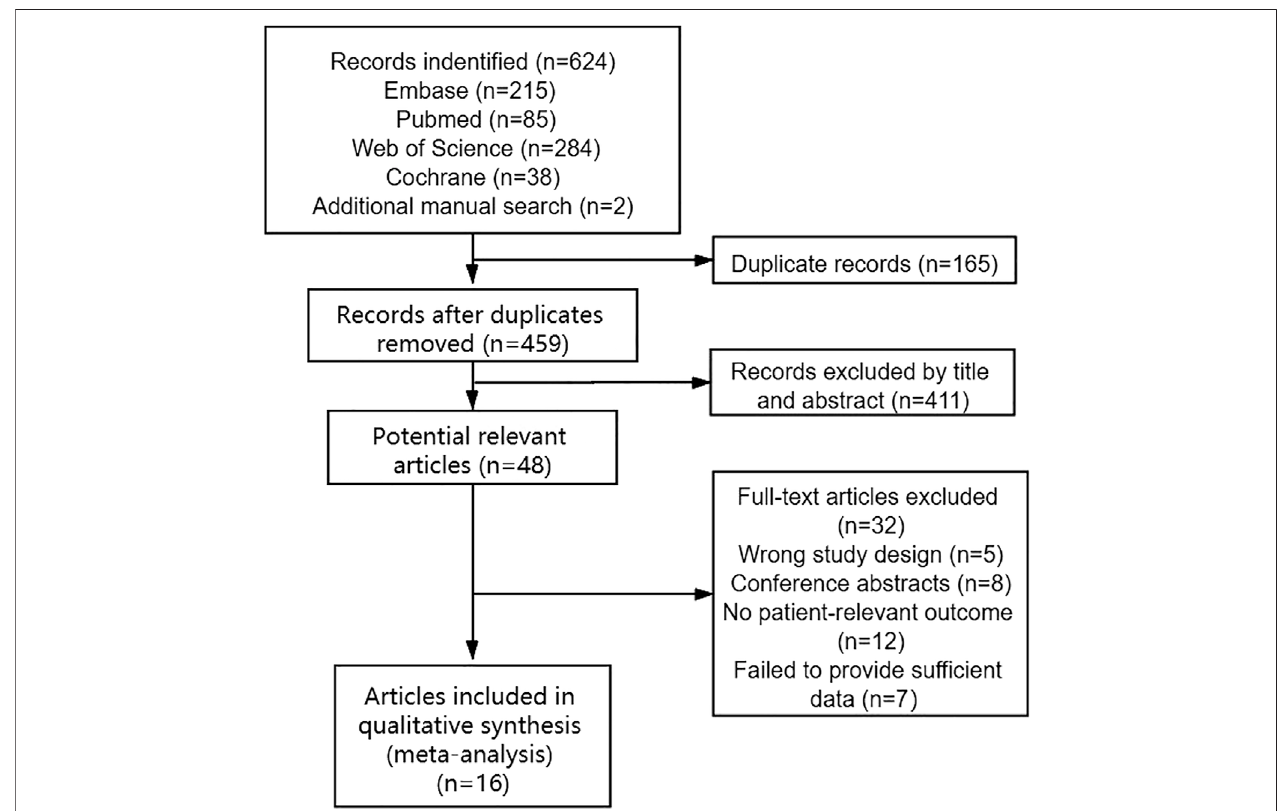
FIGURE 1 | Flow diagram for the selection of